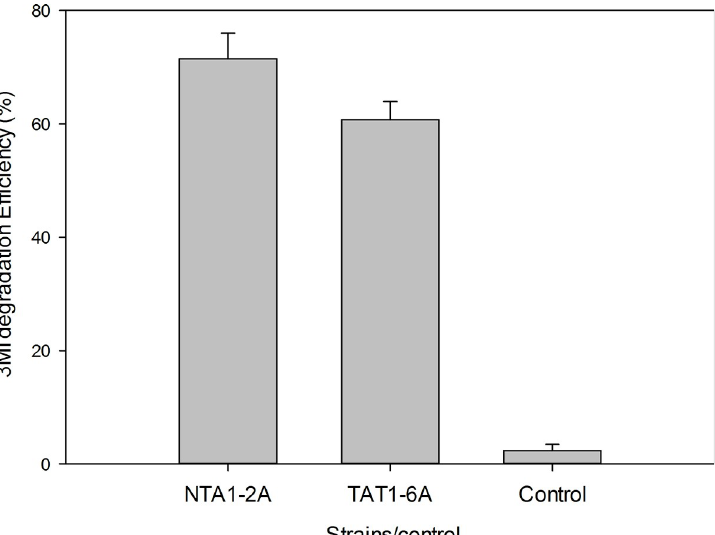
Fig 9. 3MI degradation test by extract obtained from medium cultures of NTA1-2A and TAT1-6A. Error bars: mean ± SE of three replicates.